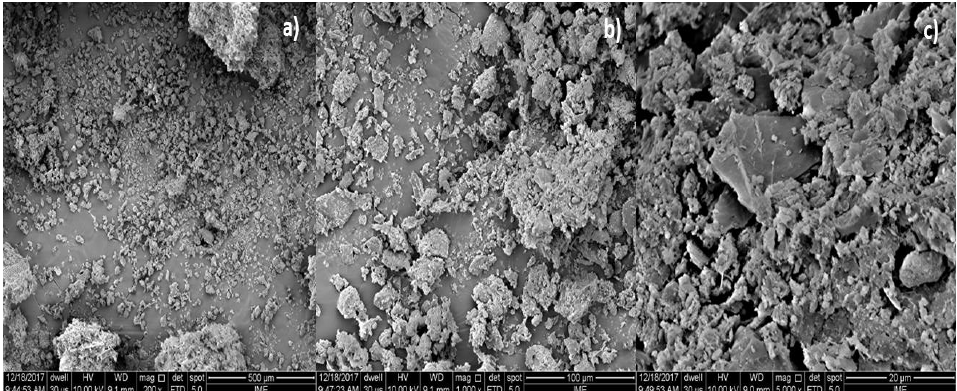
Figure 10. SEM of hydro-chars obtained by the hydrothermal processing of corn stover at 250 °C with a biomass/H 2 O ratio of 1:20 after 240 min (MAG: 200× ( a ); MAG: 1000× ( b ); MAG: 5000× ( c )).